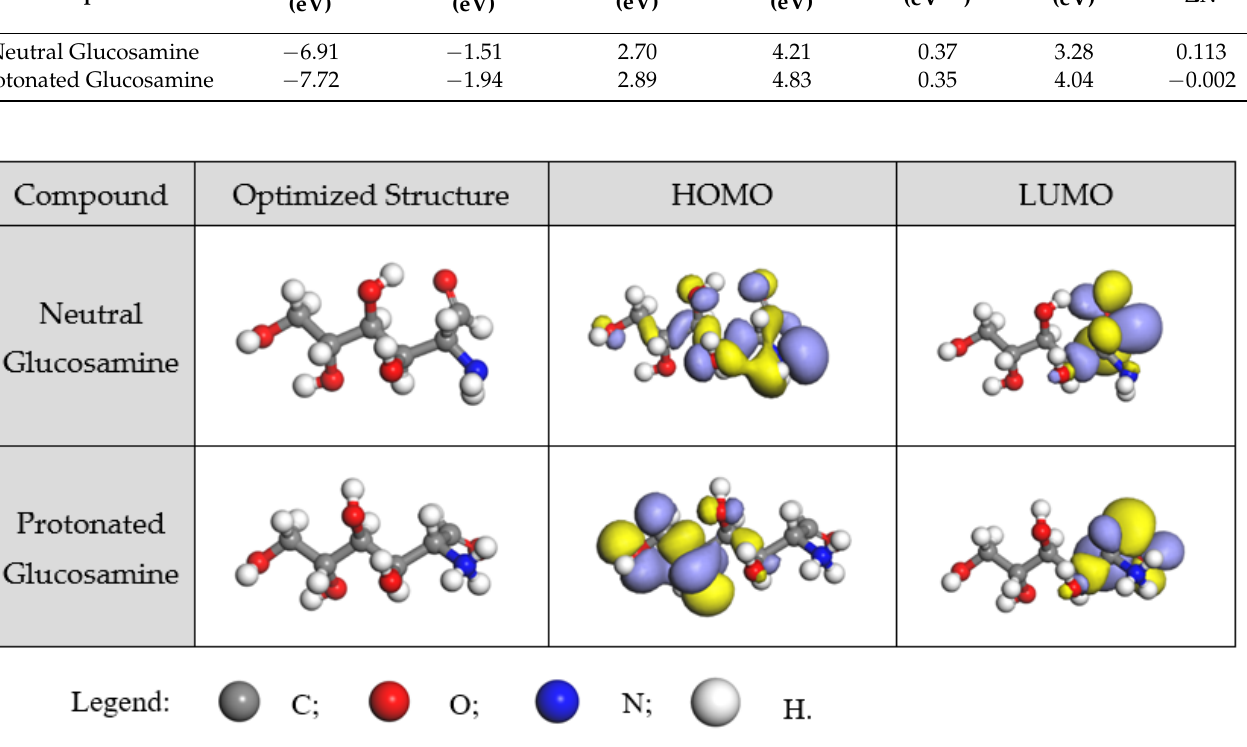
Figure 7. Optimized structures of neutral and protonated glucosamine molecules and their frontier molecular orbital density distributions.